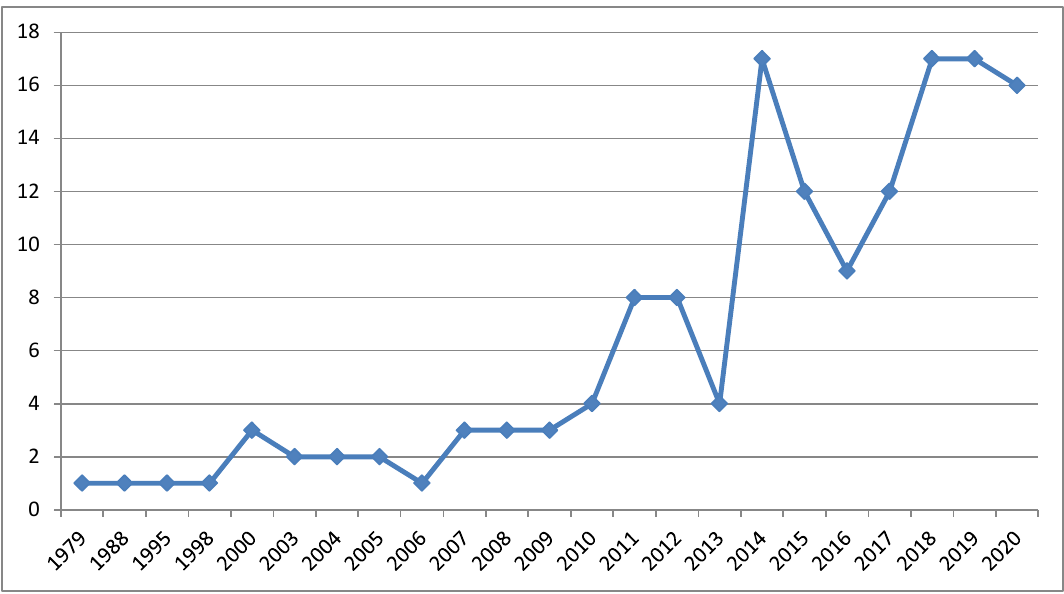
Figure 1. Distribution of the documents across years.